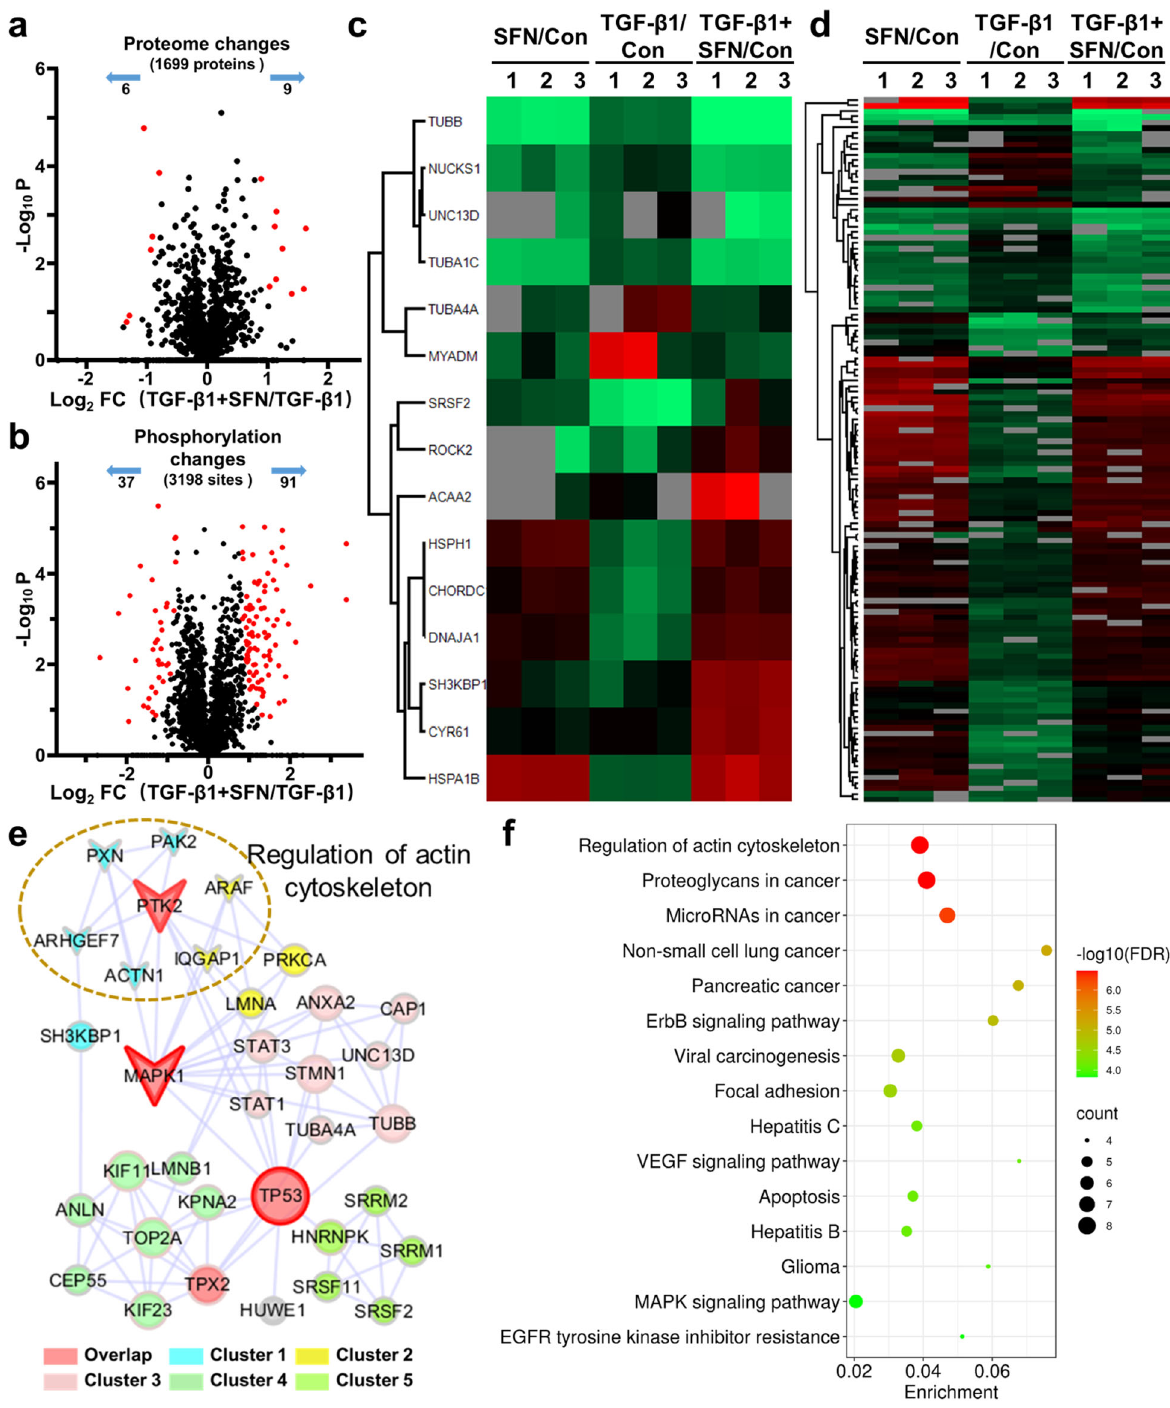
Fig. 5 Proteosomic and phosphoproteomic analysis in MDA-MB-231 cells treated with TGF- β 1 in the absence or presence of SFN. a A volcano plot shows that 15 proteins (red dots) changed signi fi cantly (FDR <0.05, S0 of 1) upon SFN treatment. b A volcano plot shows that 128 localized phosphorylation sites (red dots) changed signi fi cantly (FDR <0.05, S0 of 1) upon SFN treatment. c Cluster analysis of differentially expressed proteins. d Cluster analysis of d ifferentially expressed phosphorylation sites. e The core network of protein – protein interaction map of the altered proteins and phosphoproteins that are illustrated with color by clusters and size by degree. MAPK1, TP53, and PTK2 are in the top three degrees and served with a red border. The nodes involved in the regulation of the actin cytoskeleton are displayed by arrows. f KEGG pathways enrichment of core altered proteins and